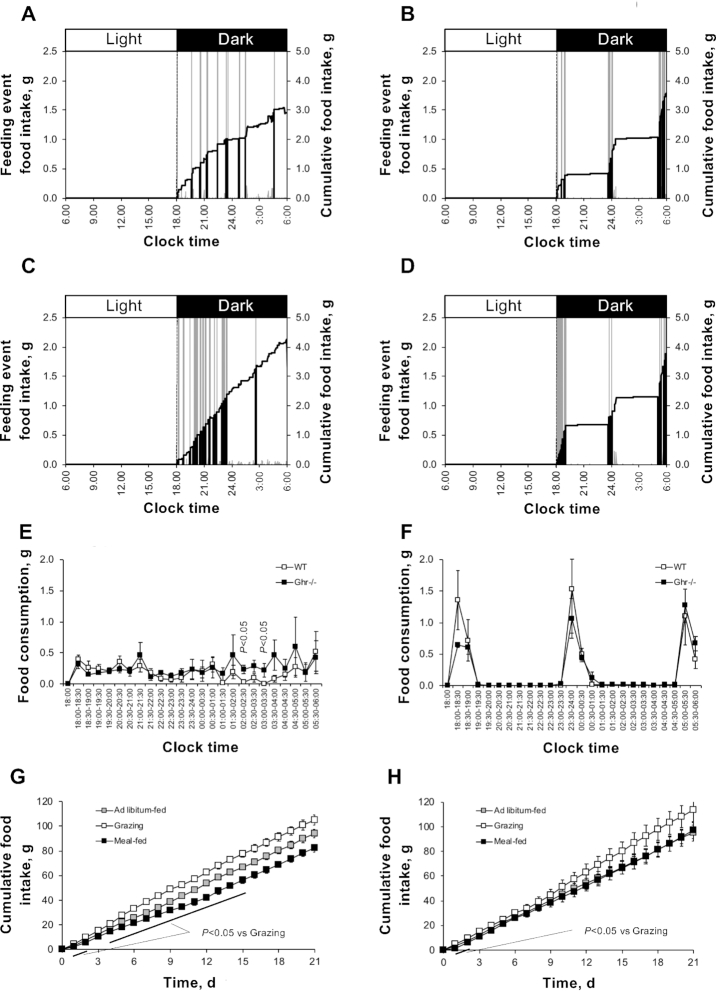
Delivery of StD in grazing and meal-feeding patterns in male WT and Ghr−/− mice (study 4). Representative daily food intake profiles from day 14 of a 3-wk study in WT (A, B) and Ghr−/− (C, D) mice fed StD (13.9% Atwater Fuel Energy fat) in either grazing (A, C) or meal-fed (B, D) patterns. Each profile shows cumulative food intake (black line; right-hand axes) superimposed onto the individual feeding events (gray bars; left-hand axes). Comparison of the mean day-14 grazing (E) and meal-fed (F) food consumption profiles in WT and Ghr−/− mice is shown, with cumulative food intake across the 3-wk study in WT (G) and Ghr−/− (H) mice presented. Data shown are either representative individual profiles (A–D) or means ± SEMs [E–H; n = 5 (grazing) and 6 (meal-fed)] with statistical comparisons performed by either unpaired Student's t test (E, F) or 1-factor ANOVA and Bonferroni's selected-pairs post-hoc test (G, H). Note: groups of ad libitum–fed WT and Ghr−/− mice (G, H; n = 8 both groups) were monitored in parallel to calculate food intake allowances for application to grazing mice. Ghr−/−, ghrelin null; StD, standard nonpurified rodent diet; WT, wild-type.